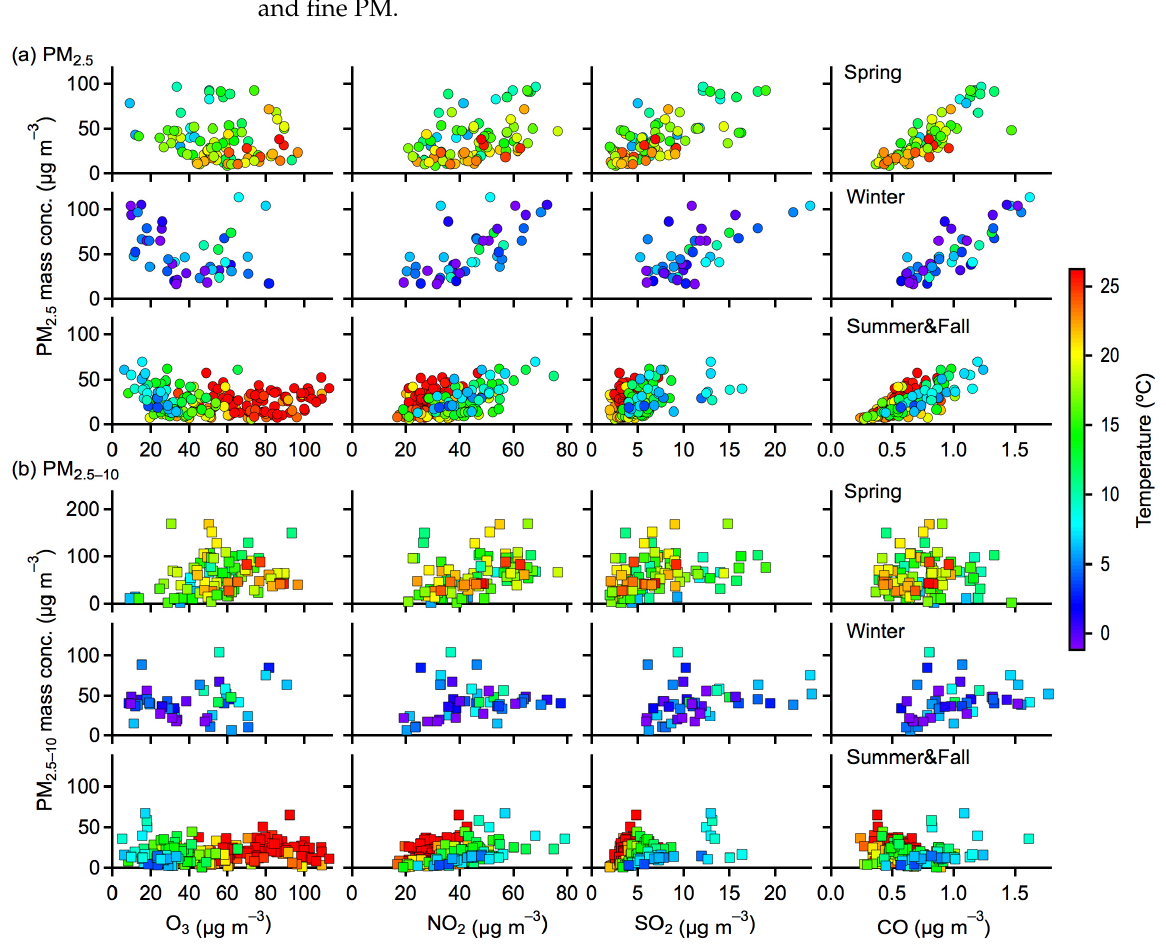
Figure 7. Correlations of the mass concentrations of ( a ) PM 2.5 and ( b ) PM 2.5–10 versus gaseous pollutants (O 3 , NO 2 , SO 2 , and CO). The markers were colored by the air temperature. Results presented here were averaged for daily data.